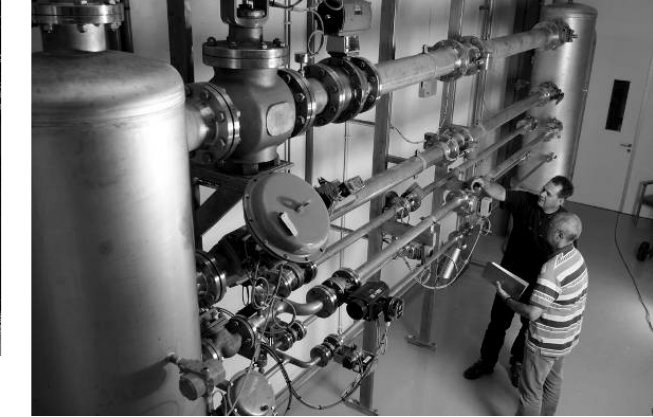
Fig. 2. Master meter section VSL water flow calibration facility.